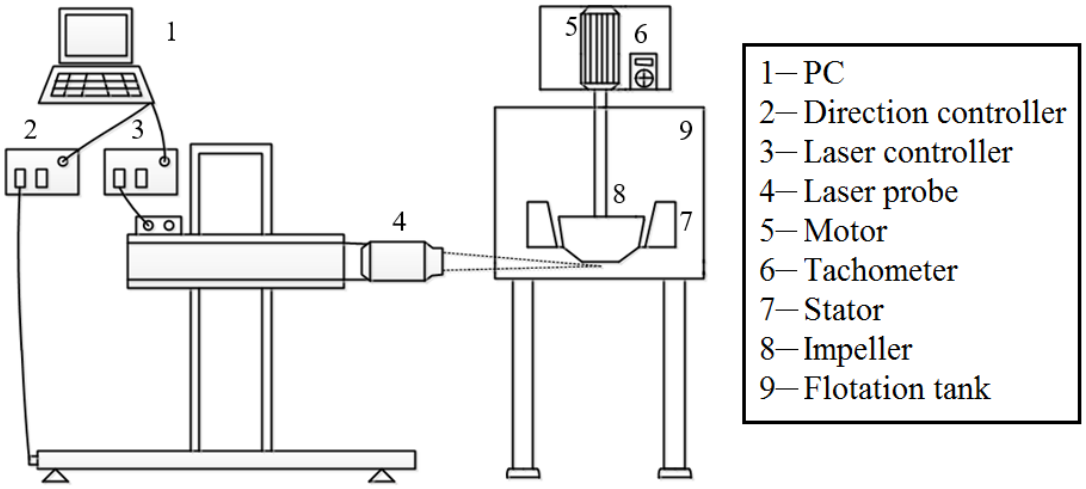
Figure 4. Schematic of the experimental system.